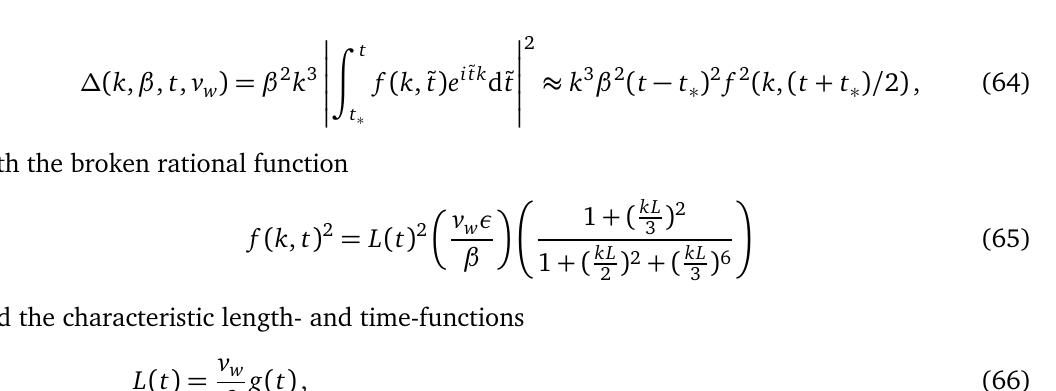
τ + τ ∗ β ev and ¯ τ : = is the time ev H ∗ 2